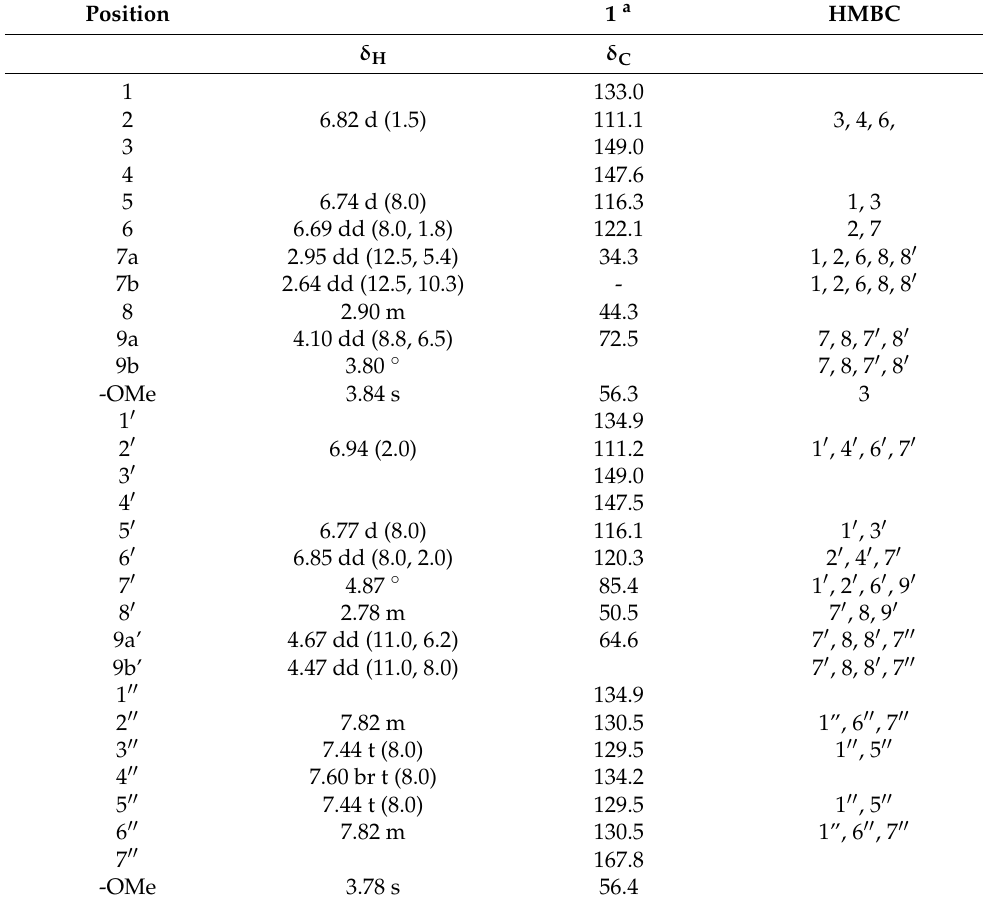
Table 1. NMR spectroscopic data of compound 1 (CD 3 OD, 600 MHz) a .